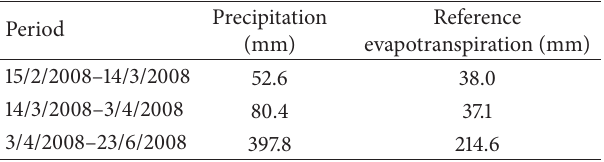
Table 3: Precipitation and reference evapotranspiration between - successive dates, in which apparent soil electrical conductivity (CE a -H) was recorded. V and CE a Precipitation Reference Period (mm) evapotranspiration (mm) 15/2/2008–14/3/2008 52.6 38.0 80.4 37.1 397.8